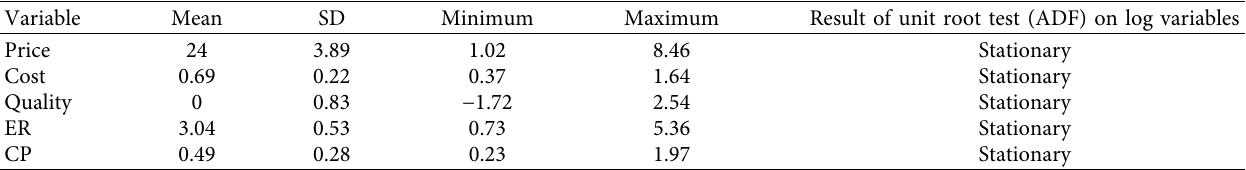
Table 6: Descriptive analysis and unit root test of variables. ER: exchange rate; CP: competition price.